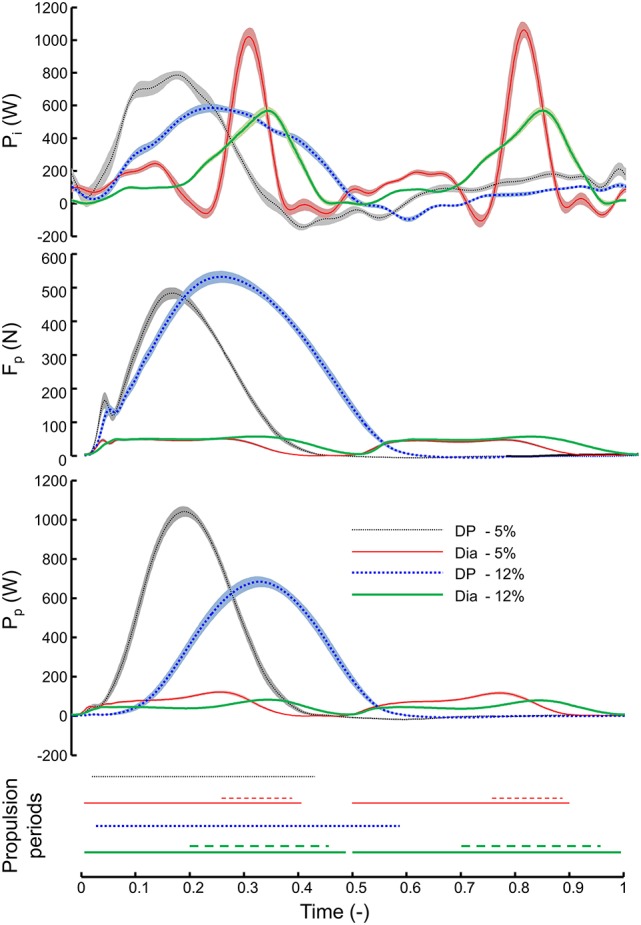
Traces (mean and s.e.m., N = 15) of instantaneous external power, pole force, and pole power against normalized time (i.e., 1 is full cycle) while roller skiing. Lower diagram indicates the periods of thrust for poles (solid or dotted lines) and skis (dashed lines). Pole force and power are the sum of left and right. Pi, instantaneous total power; Fp, pole force; Pp, pole power.